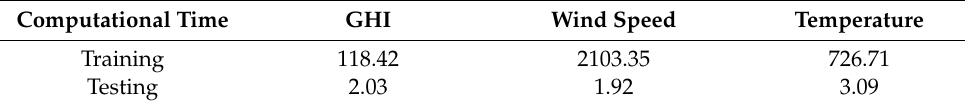
Table 6. Training and testing time in